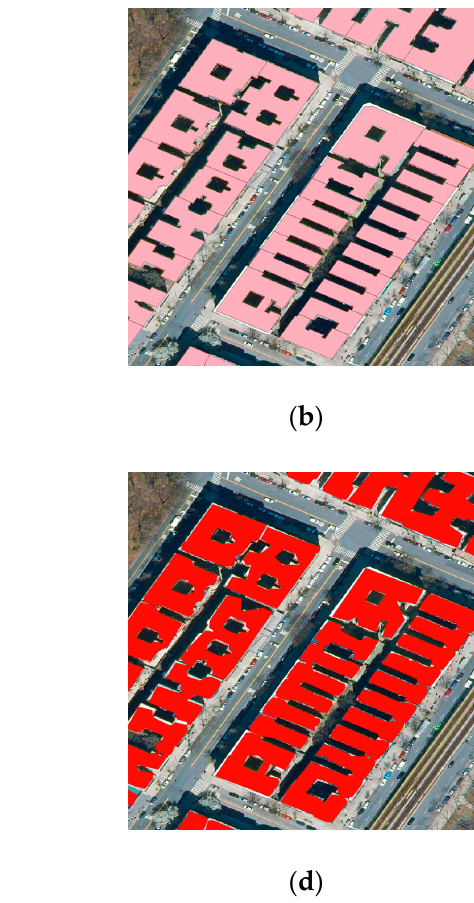
Figure 5. ( a ) Remote sensing image; ( b ) Remote sensing image overlayed with the ground truth mask; ( c ) Remote sensing image overlayed with the Microsoft predicted building footprints; ( d ) Remote sensing image overlayed with the predicted footprints using the proposed workflow based on DeepLabv3+ model (using dicewce loss function).